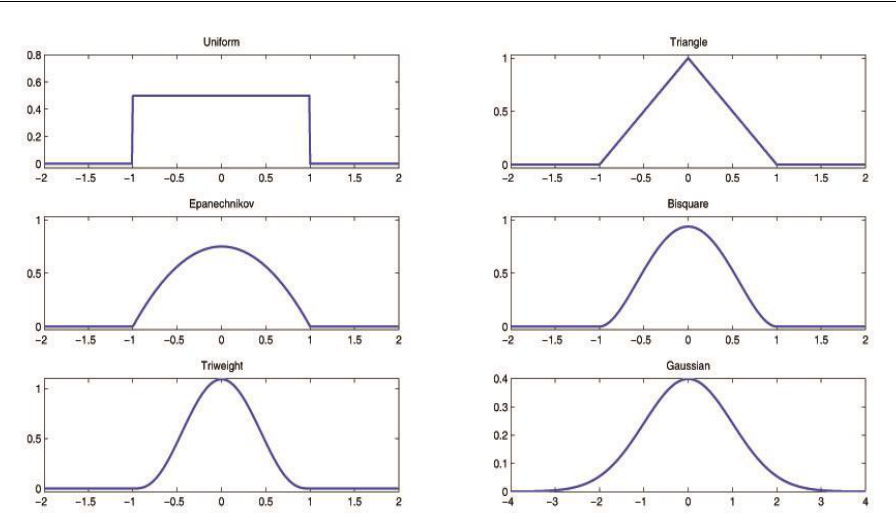
Figure 1. The six popular Kernel